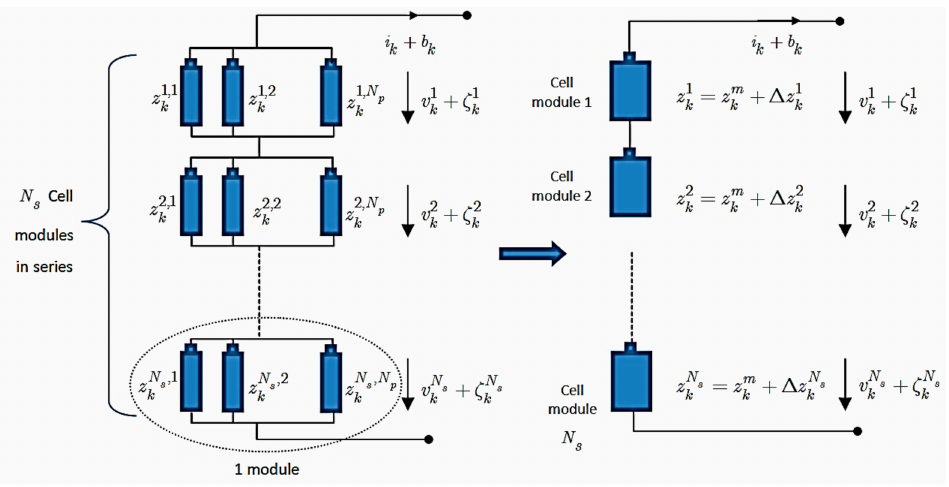
Figure 3. The model of lithium-ion battery pack